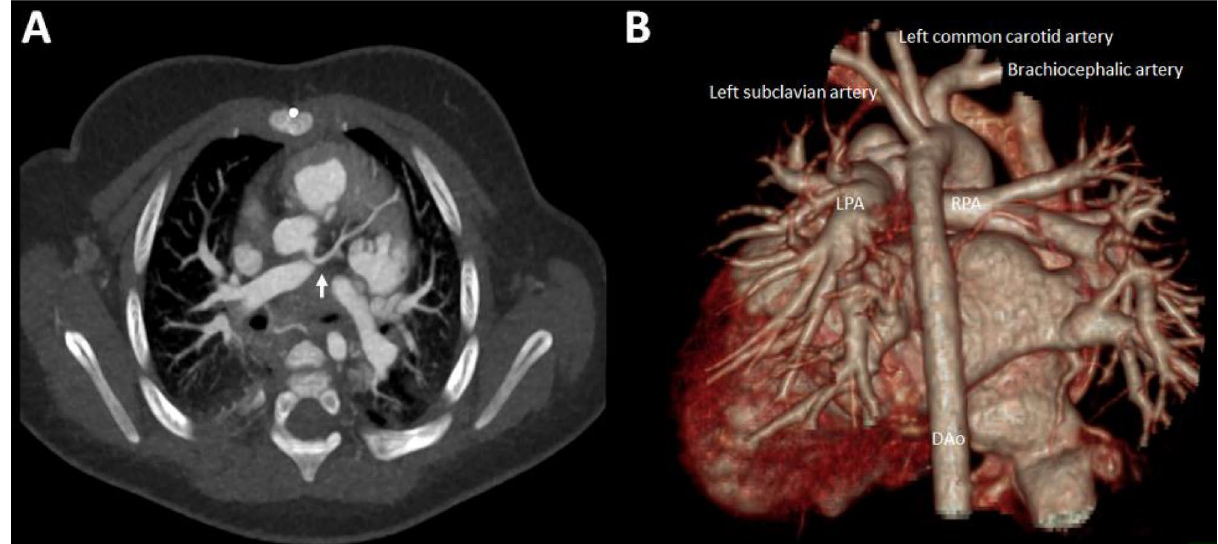
Figure 4. Pulmonary vessel anatomy in an 8-month-old female infant with a tetralogy of Fallot demonstrating good delineation of the left anterior descending coronary artery ( A ; arrow). ( B ) Dorsal view of a 3-D reconstruction of the heart and the great vessels and pulmonary veins. LPA: Left pulmonary artery. RPA: Right pulmonary artery.